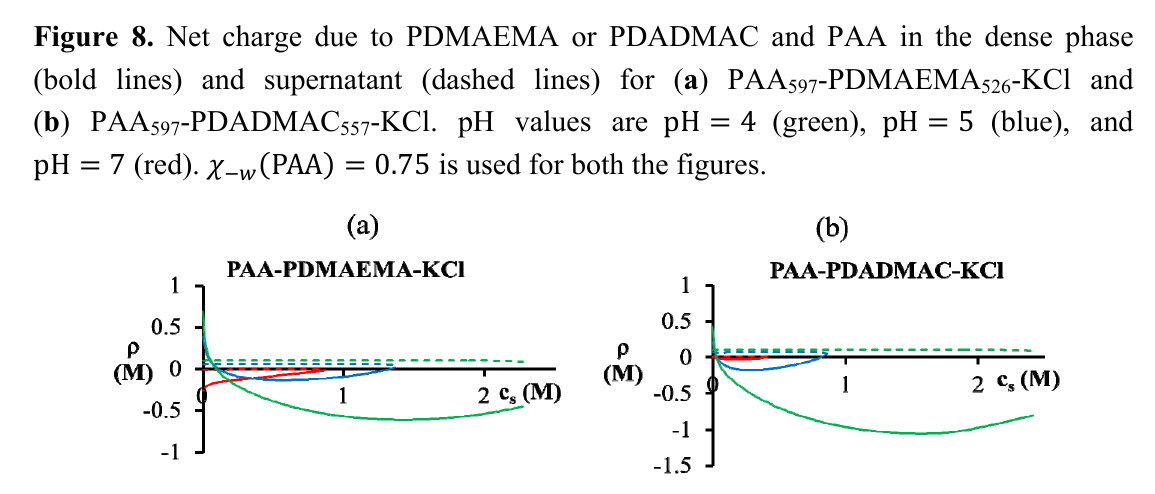
-PDMAEMA -KCl and 597 526